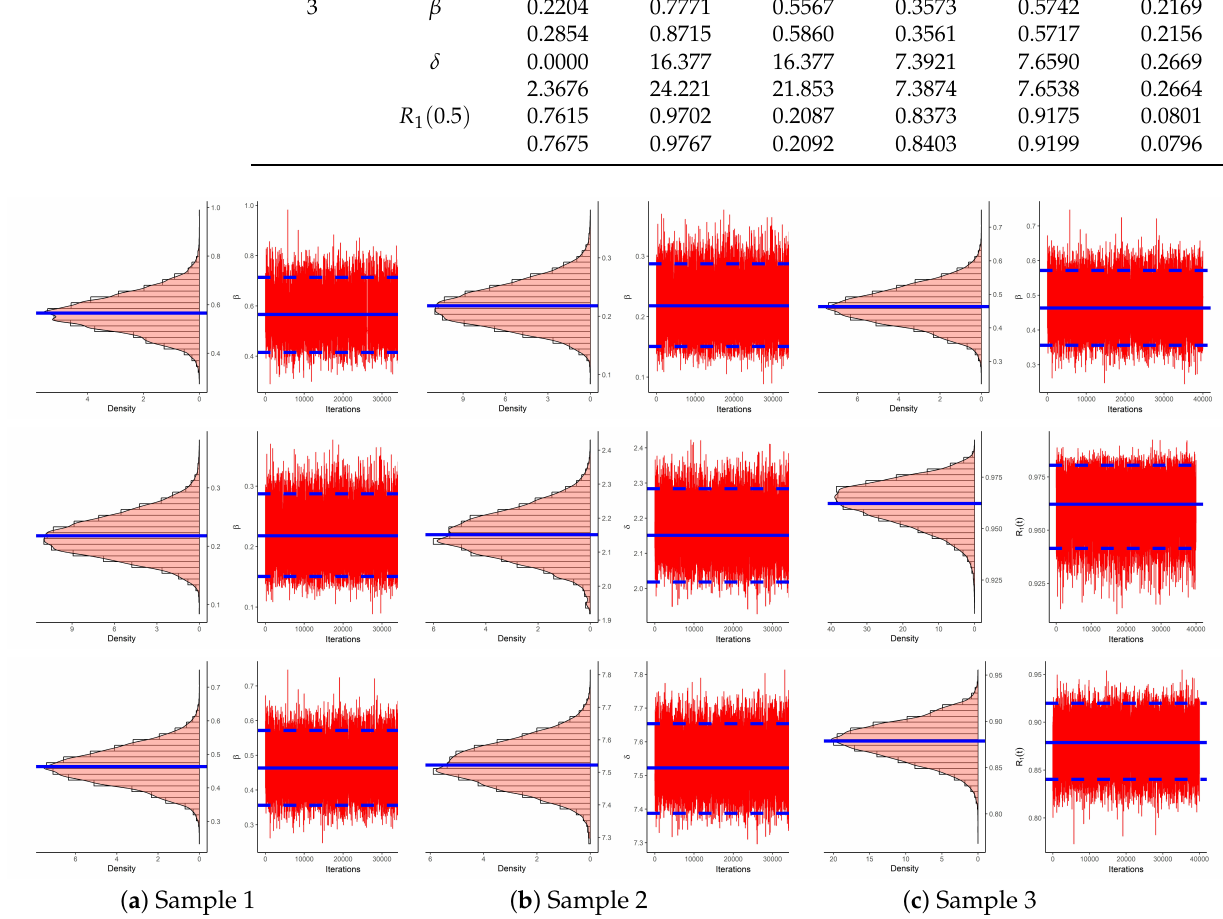
Figure 7. Density ( left ) and Trace ( right ) plot of β , δ and R 1 ( t ) from insulating fluid data. From 40,000 MCMC outputs simulated from each artificial sample reported in Table